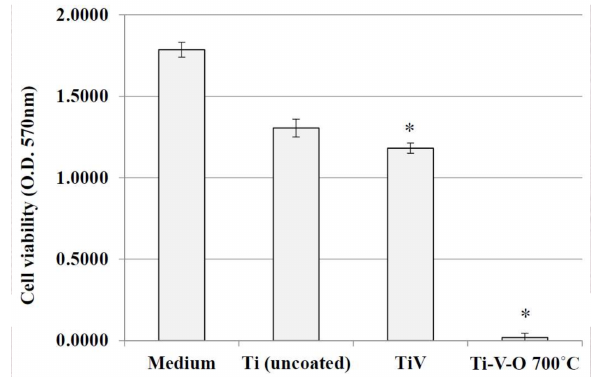
Figure 12. Cell viability of the extraction medium, Ti (uncoated) sample, TiV coating, and 700 ◦ C HTA Ti-V-O coating. * Significantly different from the control group—uncoated Ti plate ( p < 0.01).